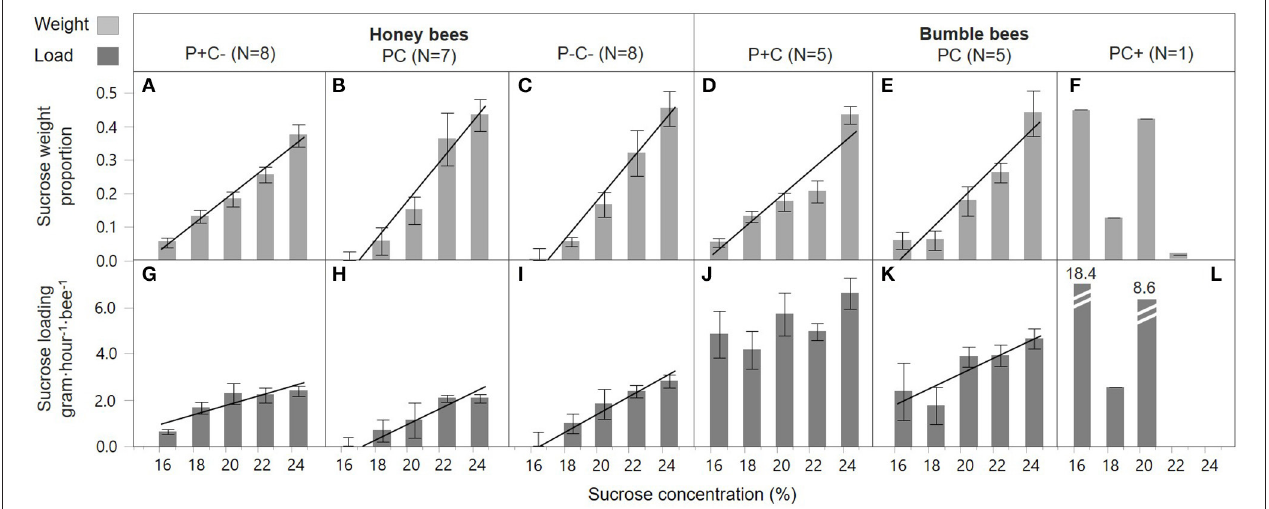
FIGURE 2 | Honey bee and bumble bee preference during sucrose collection. With the sucrose diet carbohydrate concentration in percent on the x-axis, relative sucrose collection by individual bees is shown as weight proportions on the y-axis (A–F) , and sucrose loading on the y-axis (G–L) . Trendlines indicate dose-response significance per treatment, involving protein (P) and carbohydrate (C) manipulations, within honey bee colonies (left side) and bumble bee colonies (right